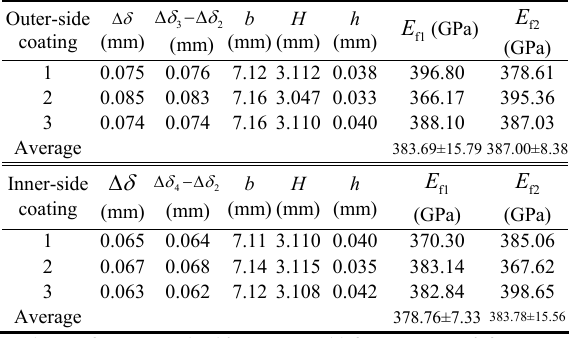
Measure data of SiC coated on graphite